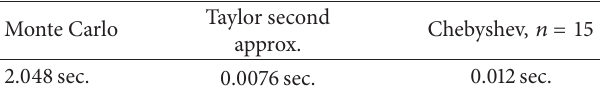
Table 2: Average routine times for Monte Carlo, Taylor, and Chebyshev approaches on a PC using MATLAB language. Taylor second Monte Carlo Chebyshev, 𝑛 = 15 approx. 2.048 sec. 0.0076 sec. 0.012